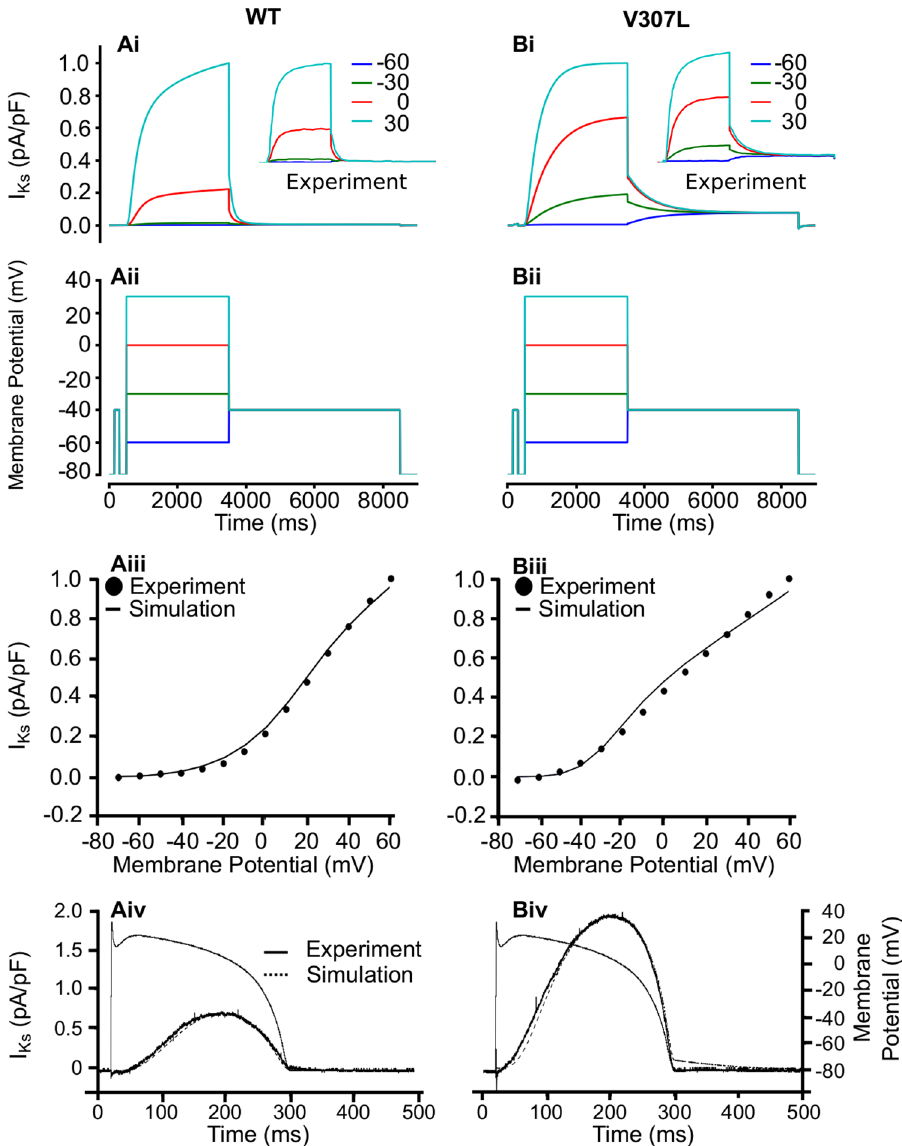
Figure 1. Simulated voltage and AP clamp experiments for I Ks . Current traces for WT ( Ai ) and V307L ( Bi ) KCNQ1 I Ks at step potentials of − 60 mV (blue), − 30 mV (green), 0 mV (red) and 30 mV (cyan) using the voltage clamp protocol shown in ( Aii,Bii ). Comparison of simulated and experimental I-V relationship for I Ks under WT ( Aiii ) and V307L ( Biii ) conditions. I Ks profile during AP clamp using a ventricular AP waveform voltage command in WT ( Aiv ) and V307L ( Biv ) conditions. All experimental data, including insets shown in panels Ai and Bi , are taken from El Harchi et al . 17